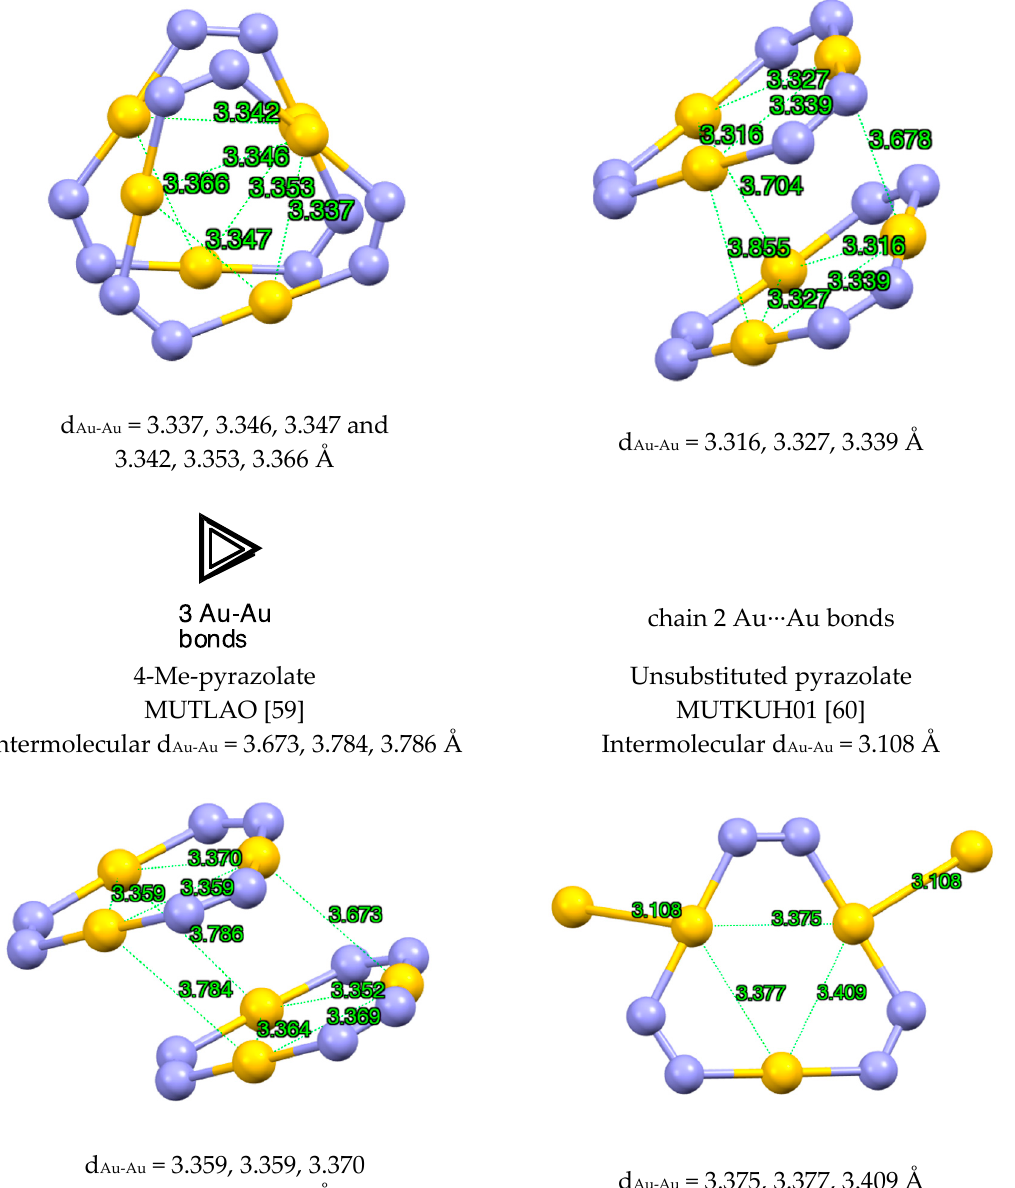
Figure 10. Different modes of (pzAu) 3 “3 + 3” complexes. Only the gold and nitrogen atoms are represented.